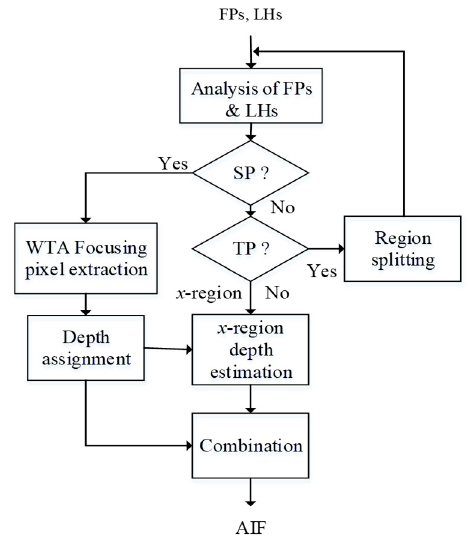
Figure 4. Flow chart of the spatial-focal analysis.